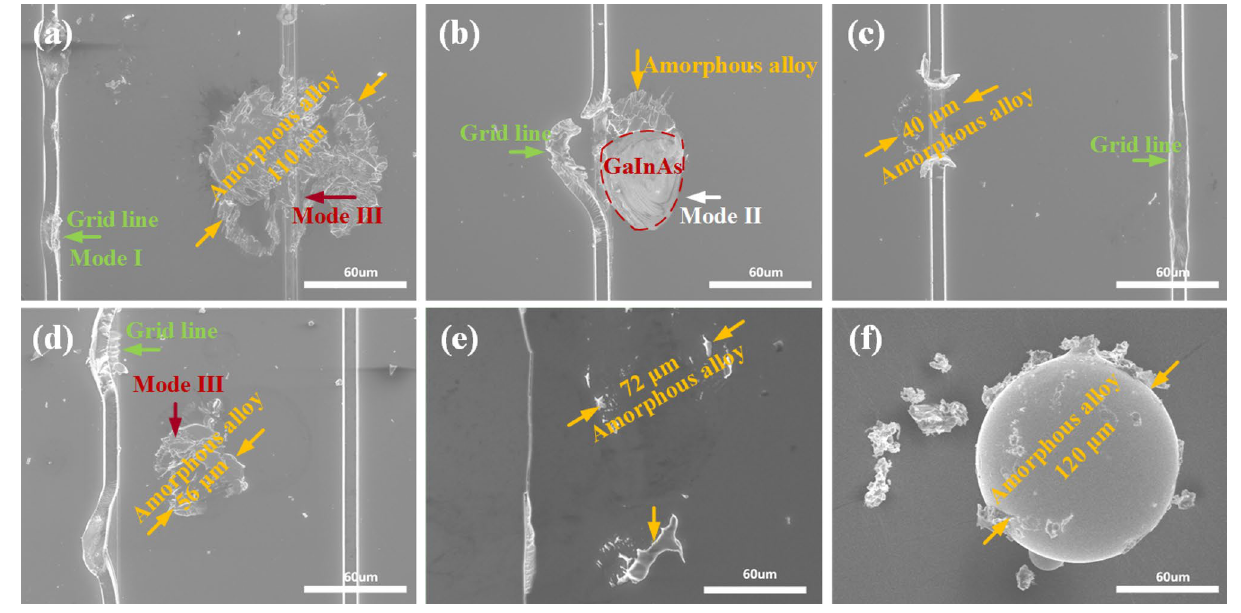
Figure 6. SEM images. ( a ) The residual particles and damage modes I and III. ( b ) The damaged PV cell sample and damage mode II. ( c–e ) The residual particles with different size after impact. ( f ) The original particle.